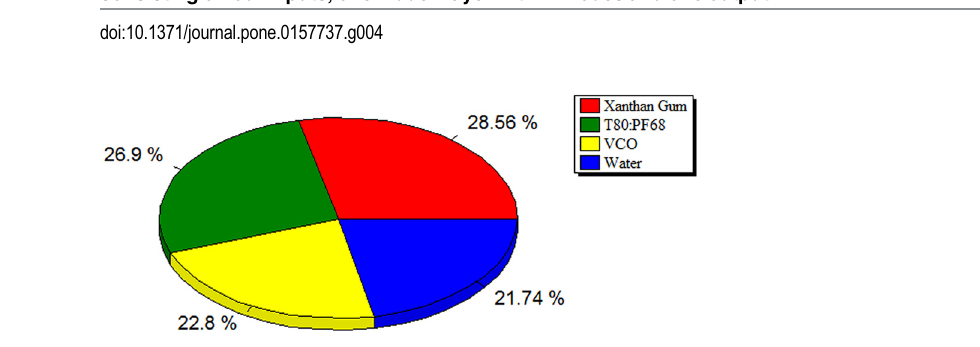
Fig 5. The relative importance of of input variables VCO, T80:PF68, xanthan gum, and water in the VCO